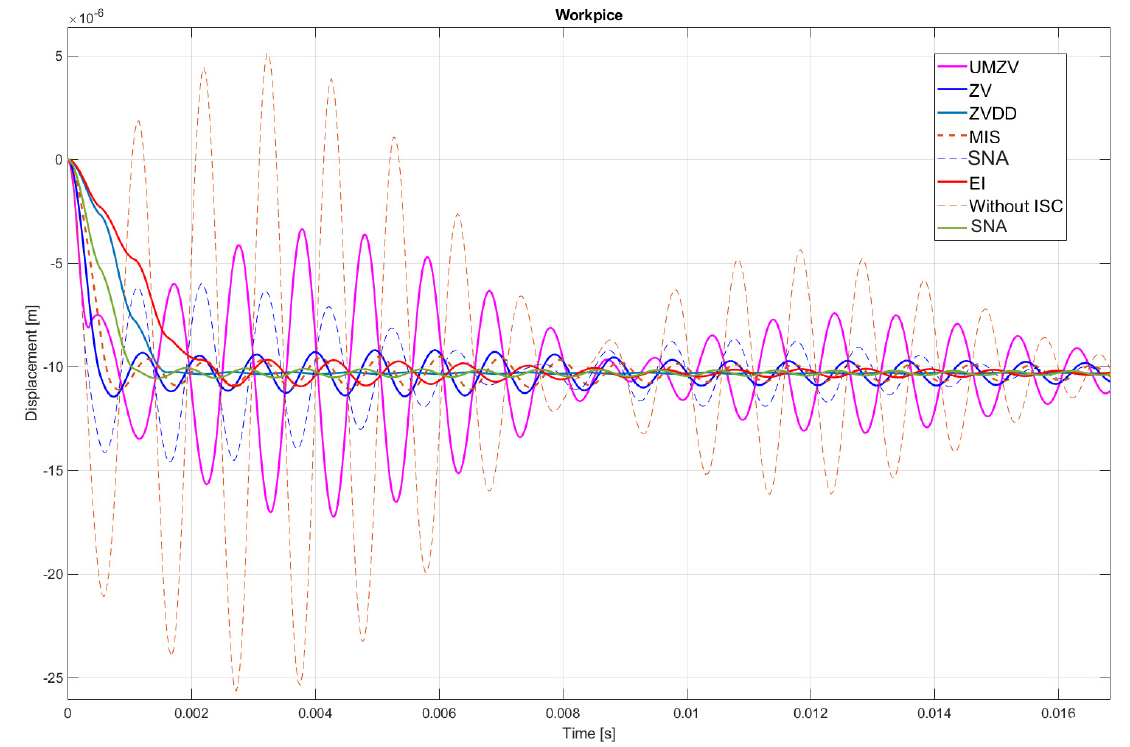
Figure 15. Work piece displacement during medium precision machining: without ISC control, using UMZV, ZV, ZVD, ZVDD, MIS, SNA and EI algorithm. Table 3. Technological parameters of the cutting process during finishing machining.